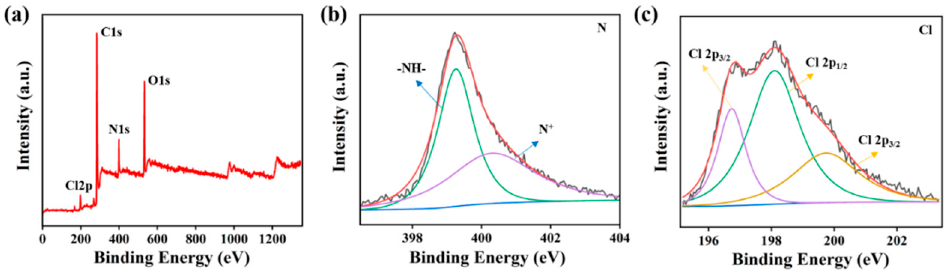
Figure 4. ( a ) XPS survey spectra, ( b ) N 1 s XPS spectra, ( c ) Cl 2 p XPS spectra of DEF/c- MWCNTs/PPy.